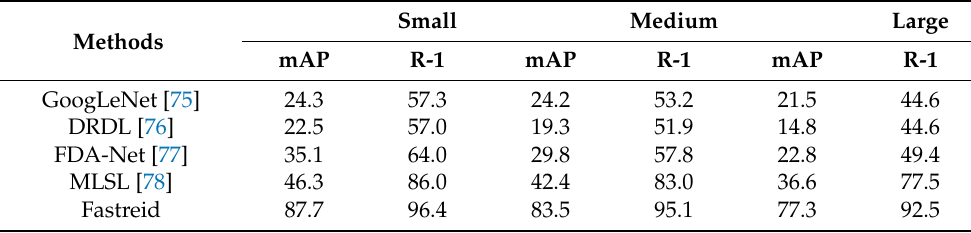
Table 10. Comparison of the state-of-the-art vehicle Re-Id methods on the VERI-Wild dataset.